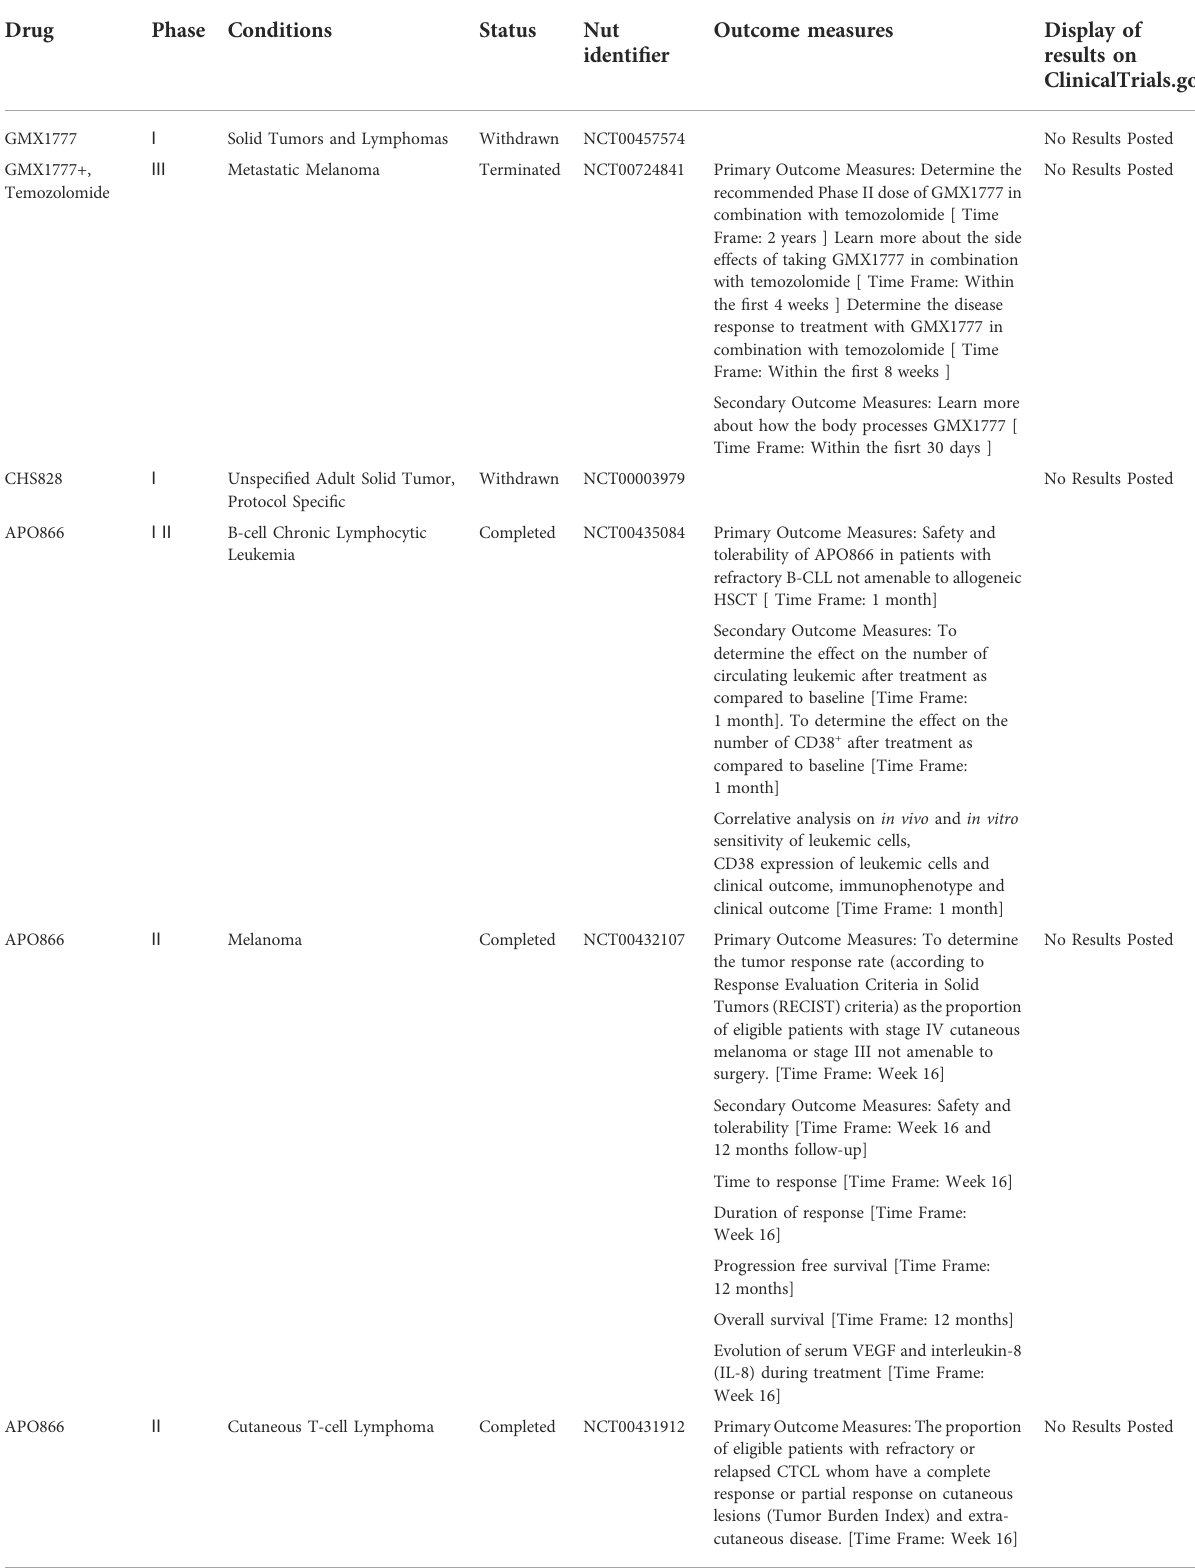
TABLE 1 Clinical trials on NAMPT inhibitors (updated to January